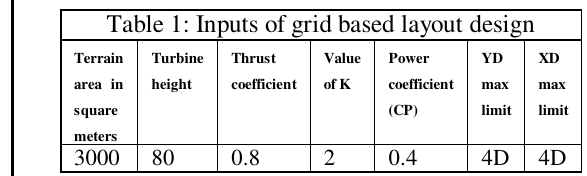
Fig. 9: Canvas output handler to show total power and total turbines 4.1. Scenario 1: Grid based layout design